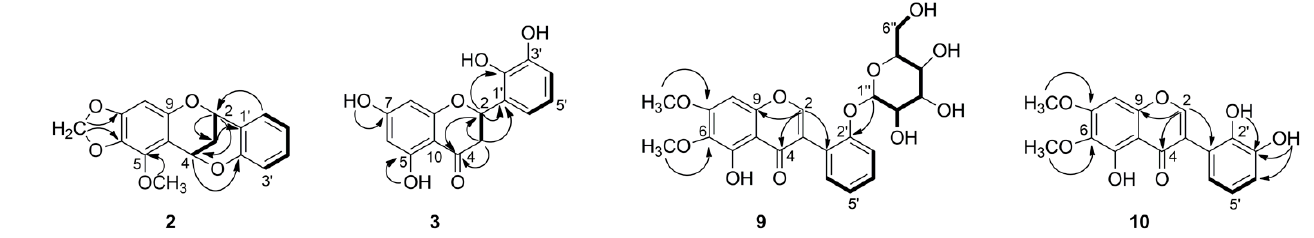
Figure 3. 1 H- 1 H COSY ( — ) and key HMBC ( → ) correlations of 2 , 3 , 9 , and 10 . The absolute configuration at C-2 of compound 3 was determined as 2S based on its Table 2. 1 H NMR (500 MHz) and 13 C NMR (125 MHz) data of compounds 2 , 3 , 9 , and 10 ( δ in ppm, J in Hz). CD spectrum (Figure S25, Supplementary Materials), which displayed a positive Cotton effect at 325 nm and a negative one at 283 nm [11,12]. Consequently, compound 3 was elucidated as (2S)-5,7,2 (cid:48) ,3 (cid:48) -tetrahydroxyflavanone, an undescribed member of a flavanone group of natural products.